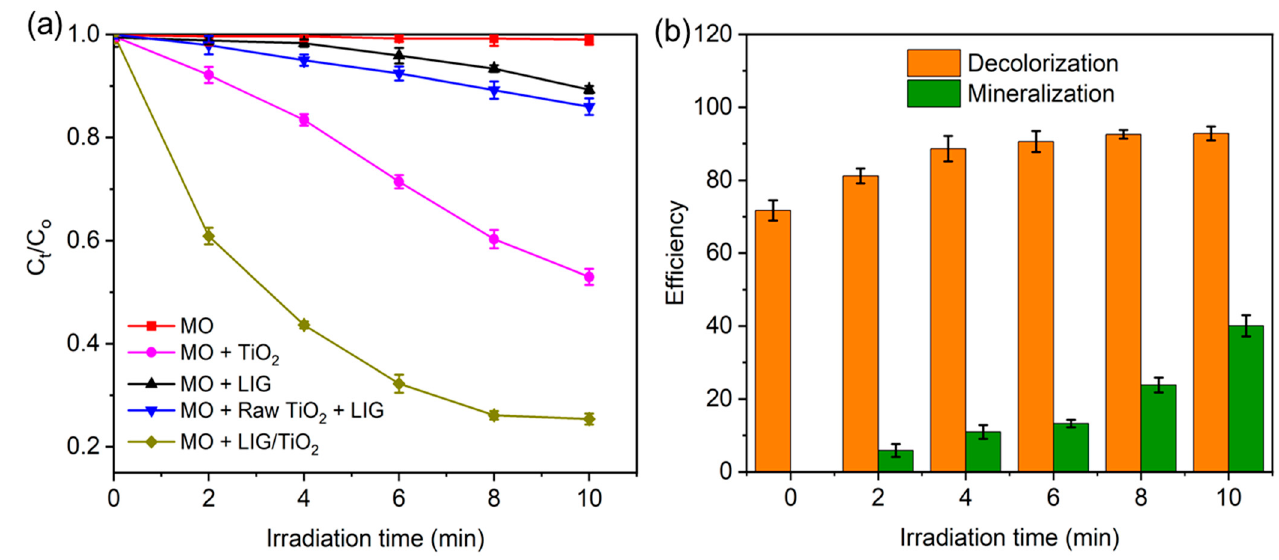
Figure 6. ( a ) Removal efficiency of MO using different catalysts (photocatalysis contribution only) at